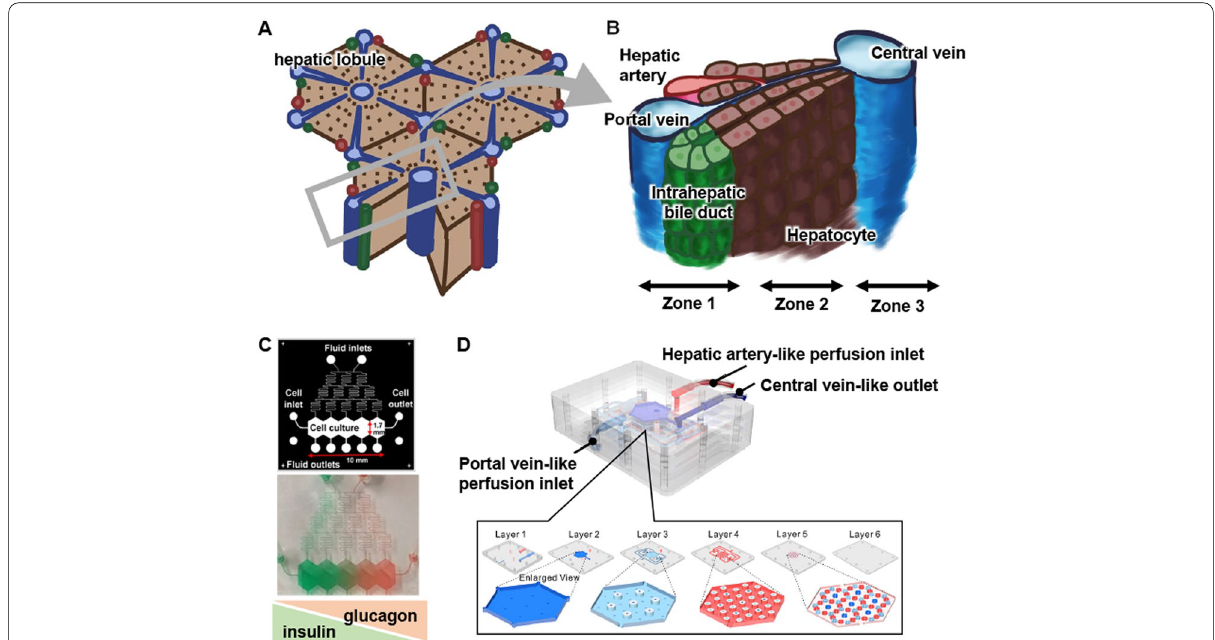
Fig. 1 Recapitulation of hepatic zonation using liver-on-a-chips. A A schematic image of hepatic lobules. B A schematic image of the hepatic cord. C The design of metabolic patterning on a chip (MPOC) with a Christmas-tree-like gradient generator. Medium containing glucagon was injected into one of the inlets of the gradient generator, and medium containing insulin was injected into the other inlet. Adapted with permission under a Creative Commons CC BY 4.0 License from ref [9]. Copyright 2018 Springer Nature. D The design of a liver lobule chip (LLC). The LLC is composed of a portal vein- and hepatic artery-like perfusion inlet and central vein-like outlet. Reprinted with permission from ref [10]. Copyright 2021 American Chemical